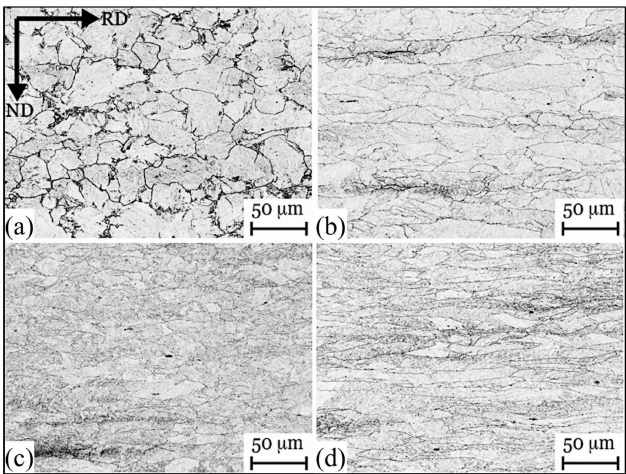
Figure 5. Parent austenite grain morphology of ( a ) 0% Mo; ( b ) 0.25% Mo; ( c ) 0.5% Mo; ( d ) 0.25% Mo +